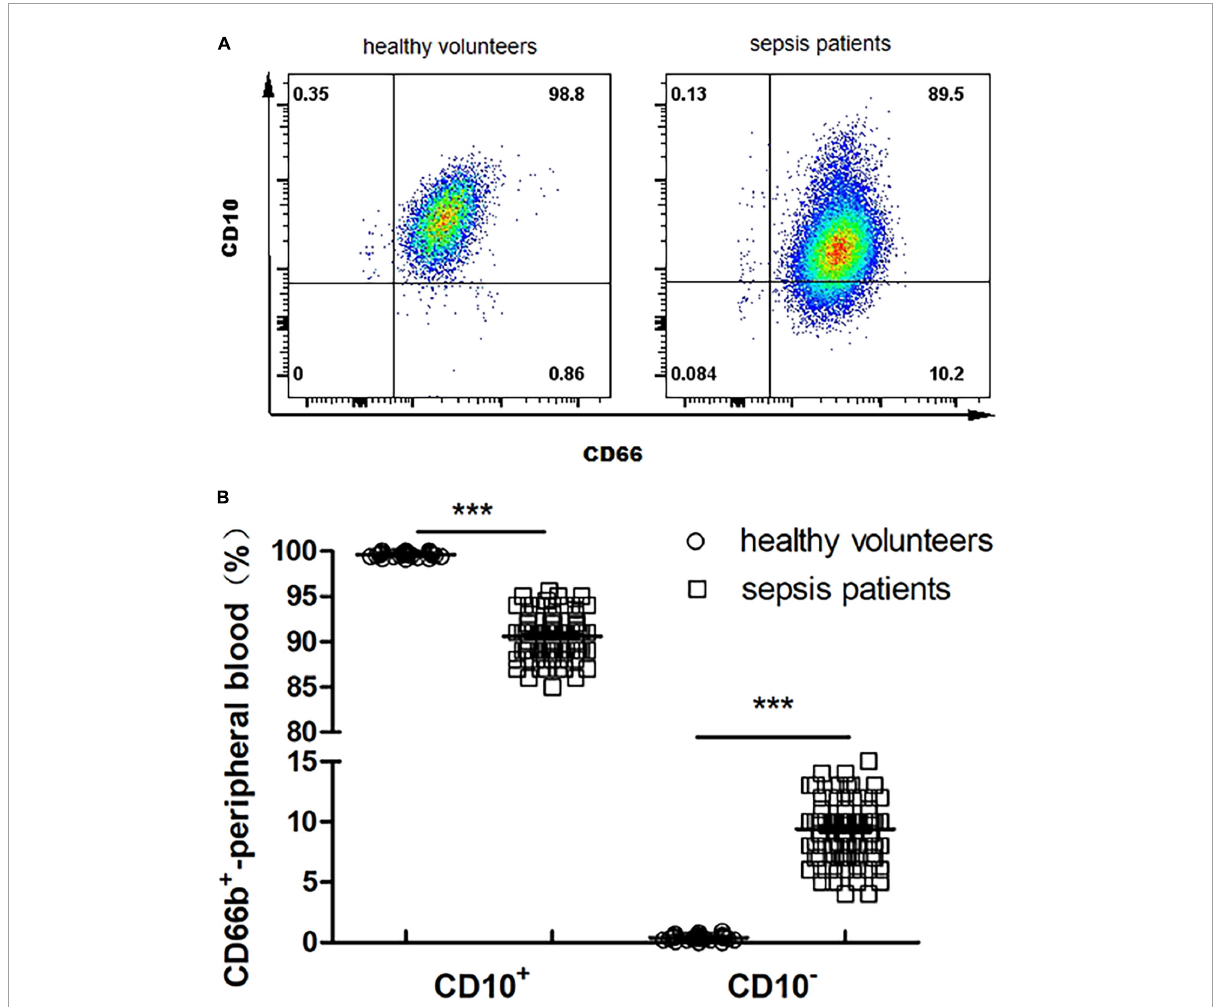
FIGURE2 (A) Proportion of CD66b + CD10 + and CD66b + CD10 − of peripheral blood in healthy volunteers (80 cases) and sepsis patients (107 cases). Representative fluorescence-activated cell sorter (FACS) plots displaying CD66b and CD10 expression in peripheral blood in healthy volunteers. (B) Frequency of CD66b + CD10 + and CD66b + CD10 − of peripheral blood in healthy volunteers (80 cases) and sepsis patients (107 cases). Graph values indicate medians from independent experiments. Each symbol stands for a single healthy volunteer or sepsis patient. *** P < 0.001, by the Mann–Whitney U